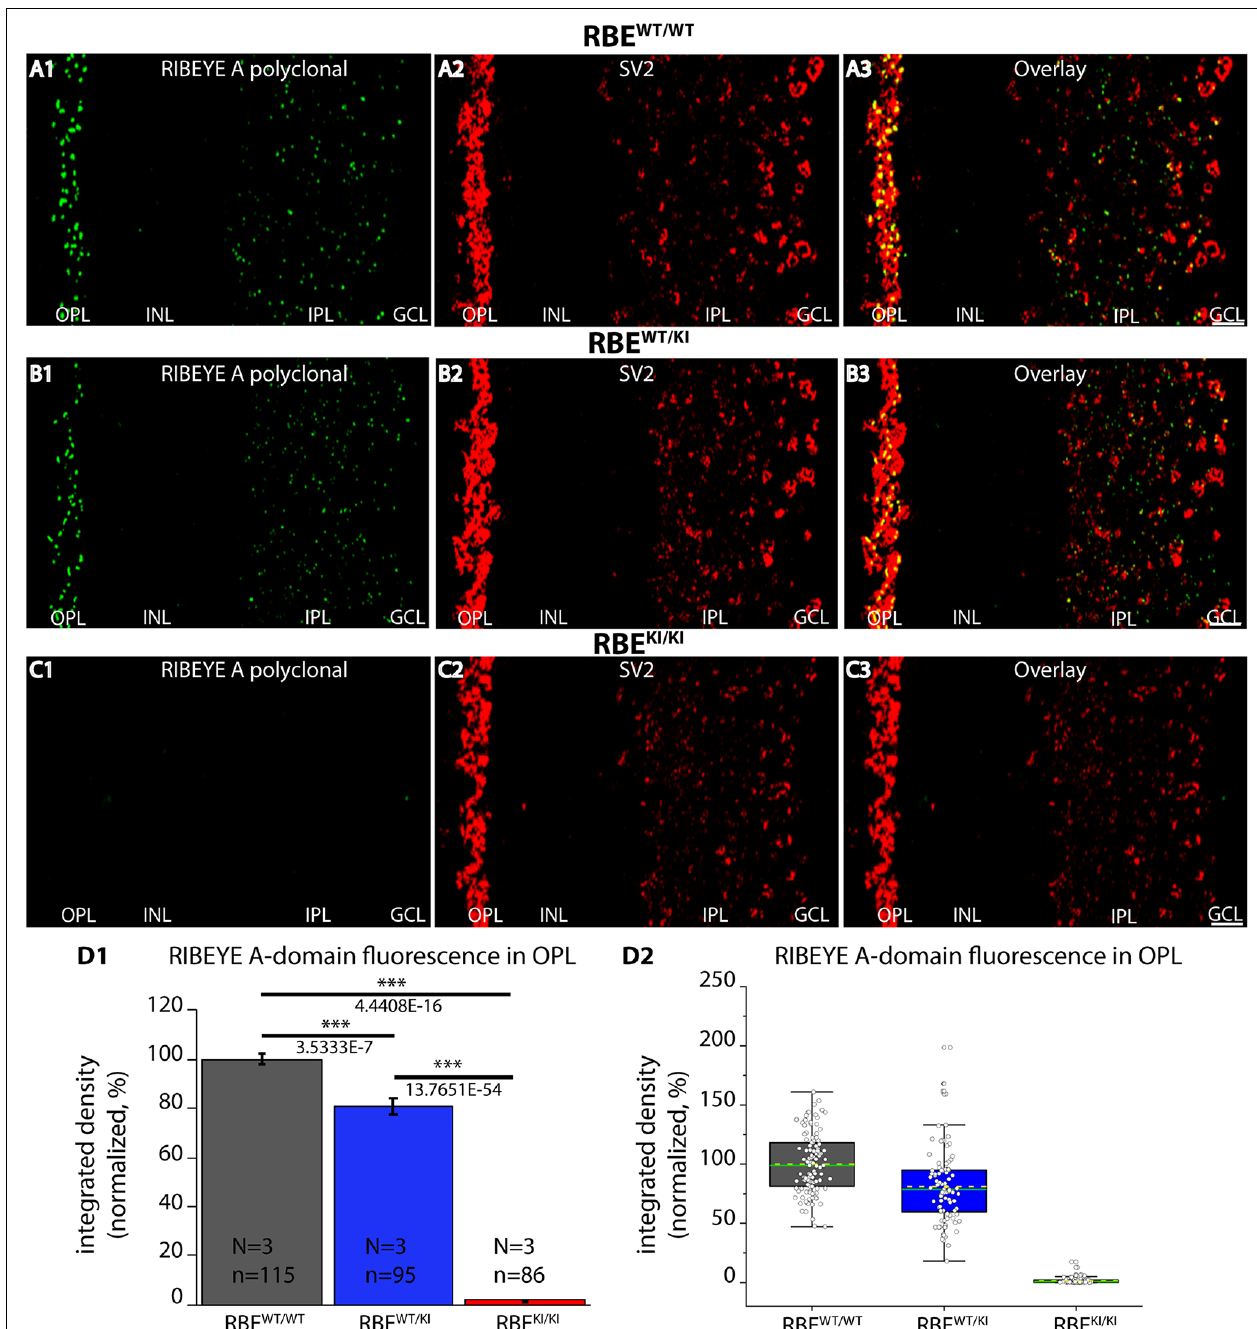
FIGURE 4 | Absence of RIBEYE A-domain immunosignals in the retina of RBE KI/KI mice. (A1–A3,B1–B3,C1–C3) 0.5 µ m-thin retina sections from the indicated littermate mice (RBE WT/WT , RBE WT/KI , and RBE KI/KI ) with mouse anti-SV2 and rabbit anti-RIBEYE A-domain (“tau”, Maxeiner et al., 2016). (C1) RIBEYE A-domain immunosignals were completely absent in the OPL and IPL of RBE KI/KI mice. (D1,D2) Quantification of RIBEYE A-domain immunofluorescence signals (as integrated density). Quantification of the immunofluorescence signals in the OPL confirmed the absence of RIBEYE A-domain immunosignals in the OPL of RBE KI/KI mice (D1) . RIBEYE A-domain immunosignals in the OPL of RBE WT/KI mice were significantly reduced in comparison to RBE WT/WT wild-type mice. Bar graphs in (D1) show means ± S.E.M. ( ∗∗∗ p ≤ 0.001). In the box and whisker plots (D2) of the data from (D1) , means values are shown as horizontal yellow dotted line and median values by horizontal green solid line. The boxes represent 25th-75th percentiles and whiskers represent 1.5 times IQR. The statistical analyses were performed with Mann-Whitney U -test and Kolmogorov-Smirnov tests because data were non-normally distributed. Abbreviations: OPL, outer plexiform layer; INL, inner nuclear layer; IPL, inner plexiform layer; GCL, ganglion cell layer; RBE, RIBEYE; S.E.M., standard error of the mean; IQR, interquartile range; N = number of mice; n = number of analyzed confocal images. Scale bar: 5 µ m.